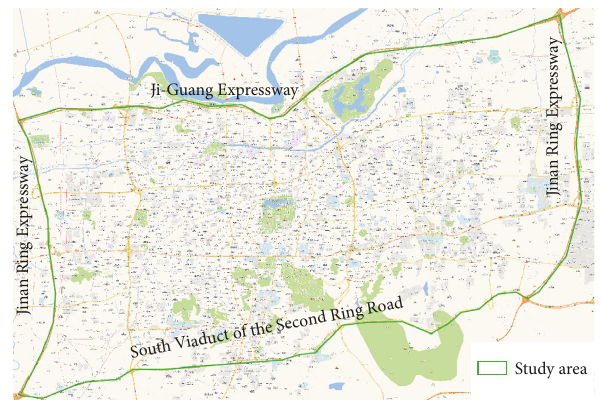
Figure 4: Study area.